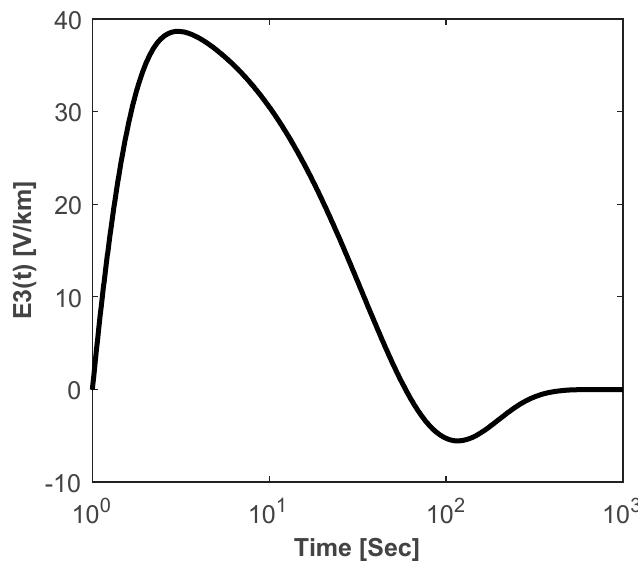
Figure 4. E3 HEMP standard developed by the International Electrotechnical Commission [3]. This figure was modified based on reference [3].